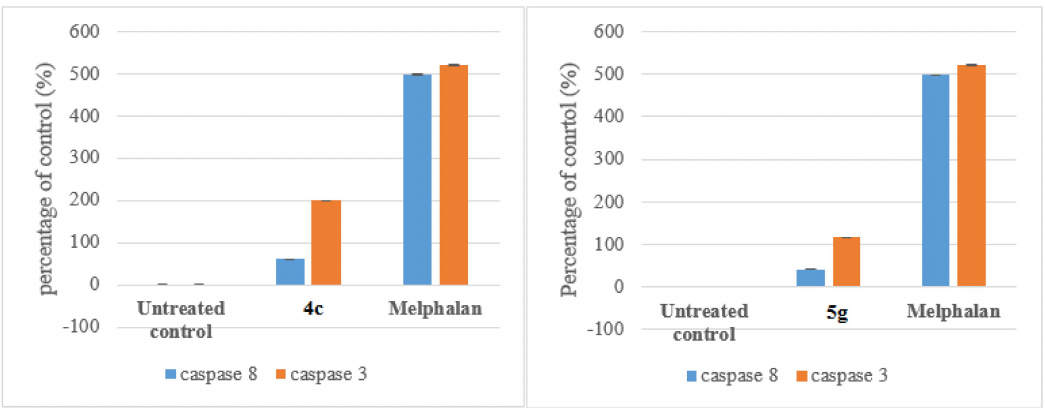
Figure 3. Caspase 8 and 3 activation as indicated by % changes in the mean integrated fluorescence inensity of the untreated control using A549 cells after 24 h of exposure to 4c and 5g (IC 50 values) using Melphalan as a positive control. Bar graph represents the average of one individual experiment performed in quadruplicate. The standard deviations are represented as error